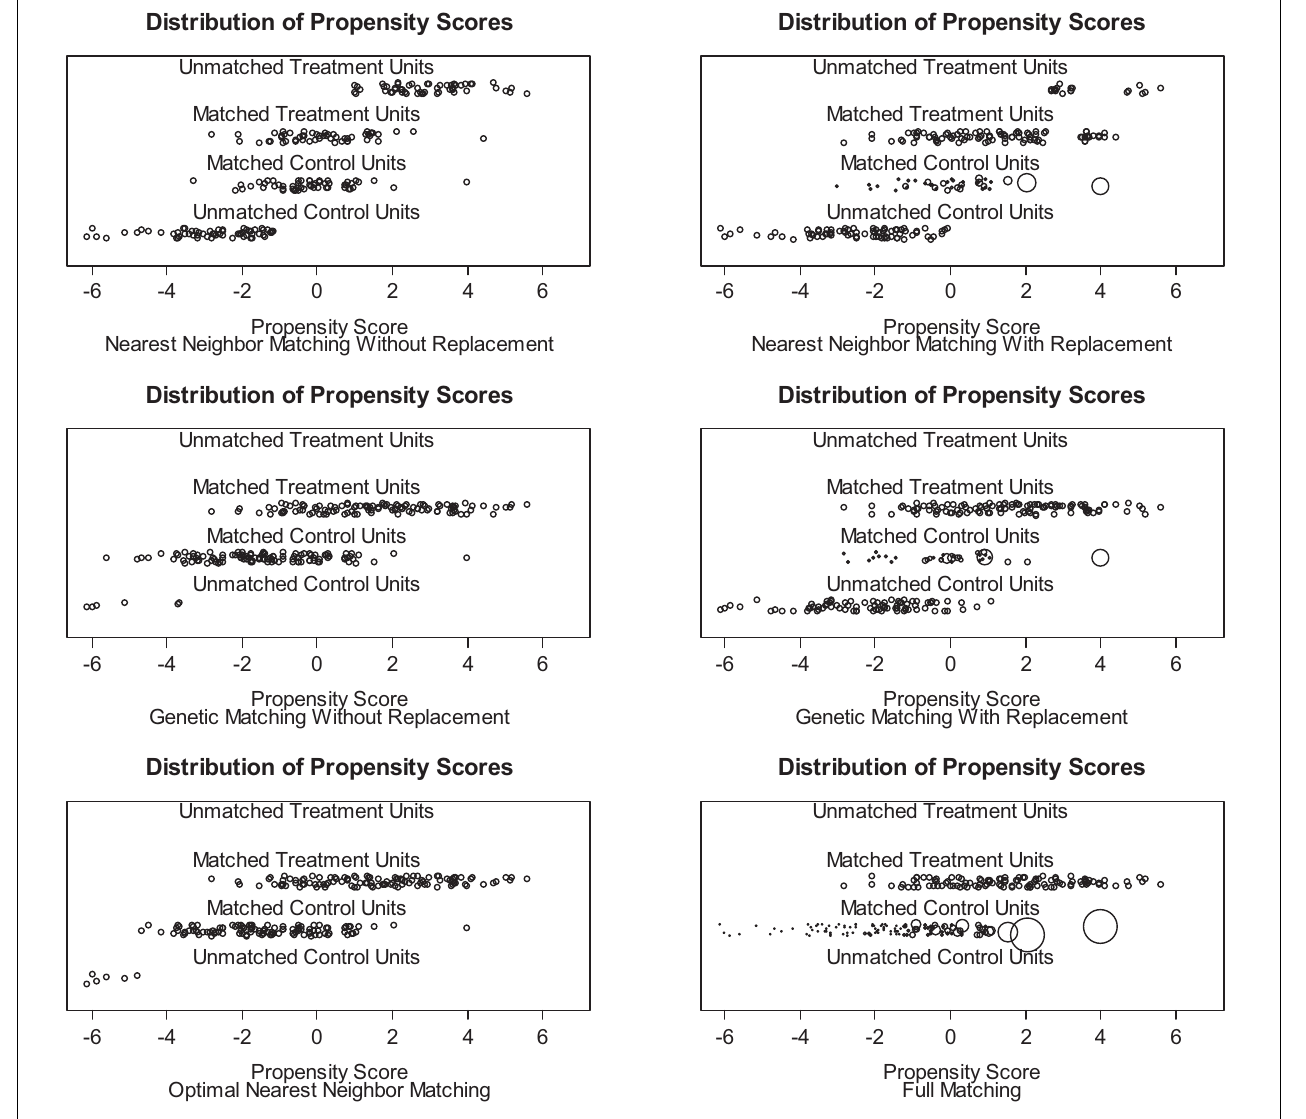
FIGURE 2 | Jitterplots displaying the distribution of propensity scores after six different matchings. Circle sizes indicate the assigned weights for group comparison regarding the treatment effect.